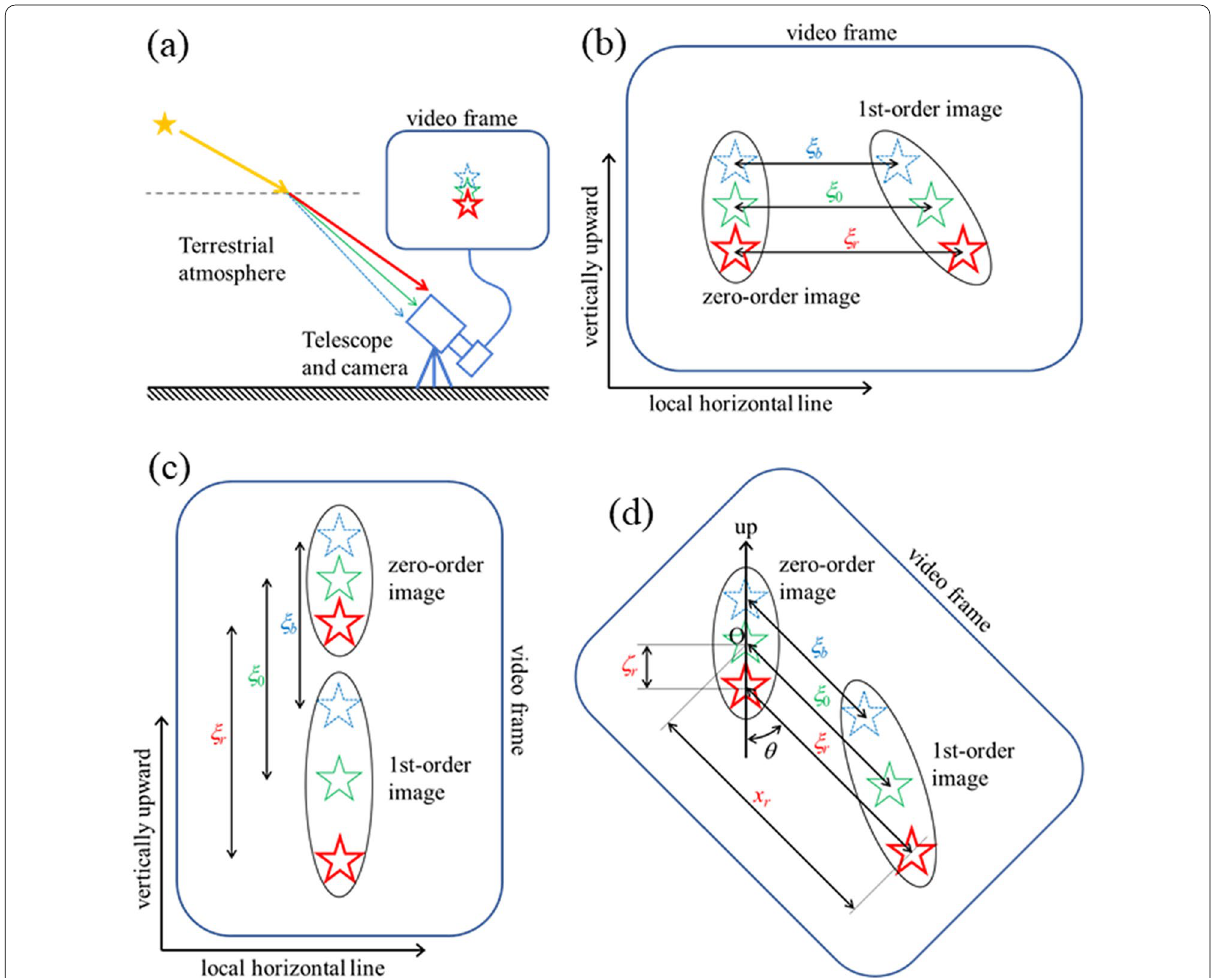
Fig. 9 a Atmospheric dispersion due to the wavelength dependence of the refraction angle of light rays from a star in the terrestrial atmosphere. The dispersion makes the blue image up and red image down relatively and leads to a vertically elongated star image. b When the horizontal direction of the frame, that is, the dispersion direction of our spectral camera, is parallel to the local horizon, the horizontal distance, ξ b , ξ 0 , and ξ r are related to wavelengths based on the dispersion relation of the camera described in section "Wavelength calibration". c When the dispersion direction of the camera is perpendicular to the local horizon, as shown here, the 1st-order spectral image elongates, though ξ b , ξ 0 , and ξ r do not change. d In general cases, the dispersion direction makes an angle θ with the local vertical. See text for further